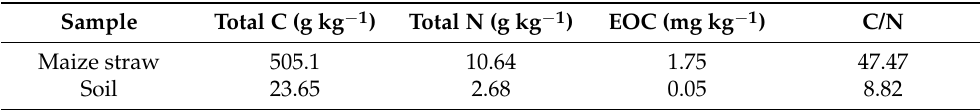
Table 1. Total N, total C, easily oxidized carbon (EOC) content and C/N ratio of maize straw and the soil used in this study.